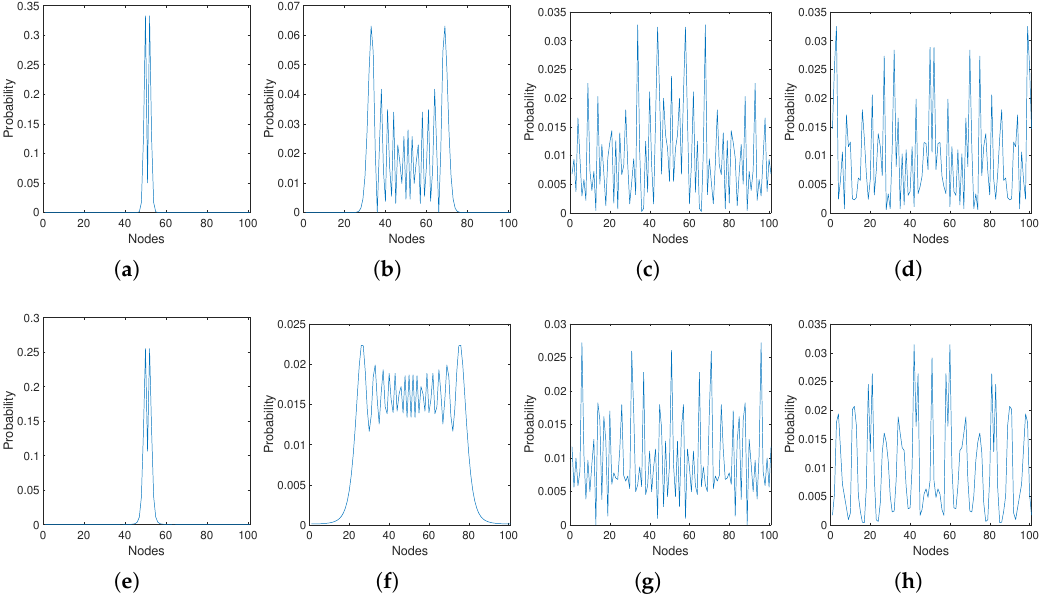
Figure 4. Probability at every node of a ring of 101 nodes using the Schrödinger equation without LRI ( a – d ) and with Mellin transform using s = 2 ( e – h ). The probability at t = 0 is equal to one at the node 51 and zero elsewhere. The plots correspond to times t = 1 ( a , e ), 10 ( b , f ), 100 ( c , g ), 1000 ( g , h